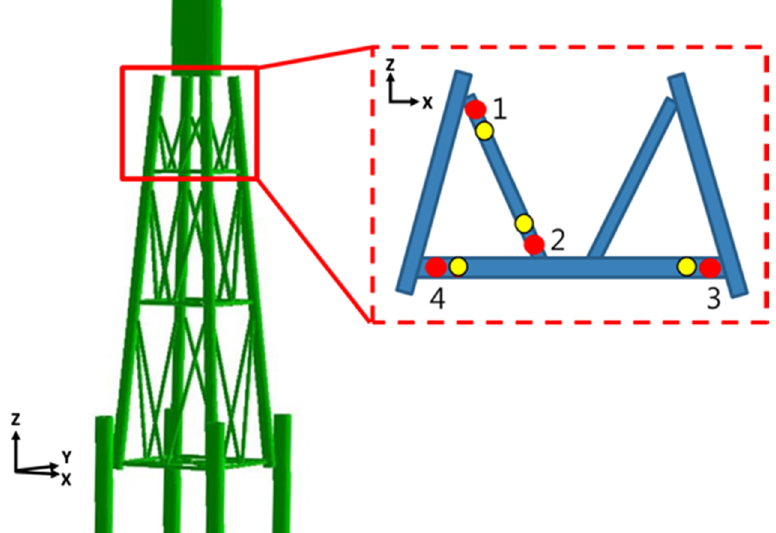
Figure 3. Jacket support structure numerical model (yellow and red points are measured and expanded points, respectively). Table 1. Pipe damage scenarios.